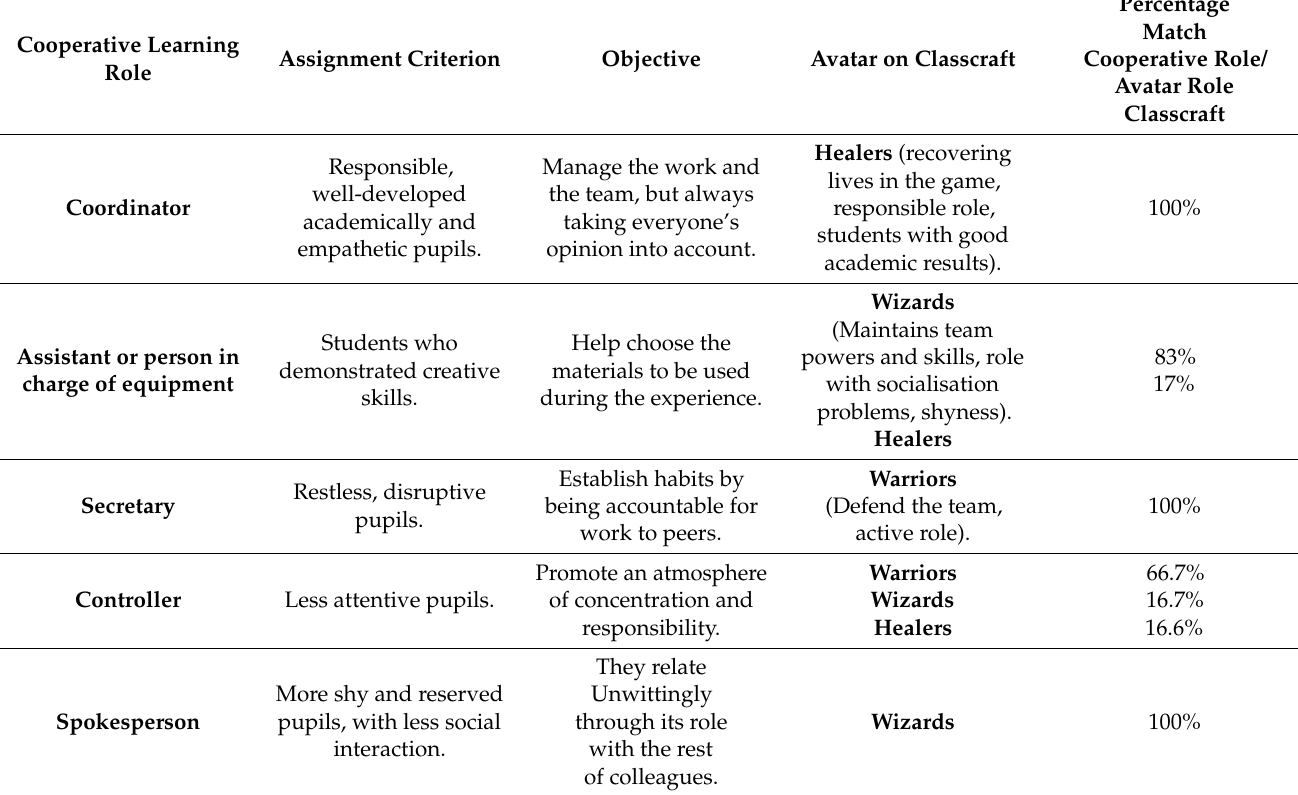
Table 1. Relationship between cooperative learning roles and Classcraft roles.